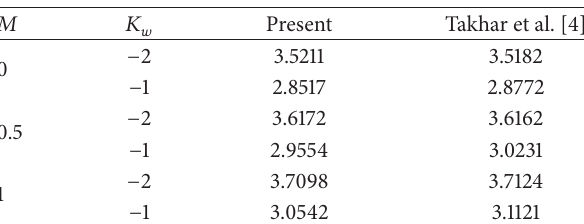
Table 1: Values of 𝑓 󸀠󸀠 (0) for different values of 𝑀 and 𝐾 𝑤 < 0.